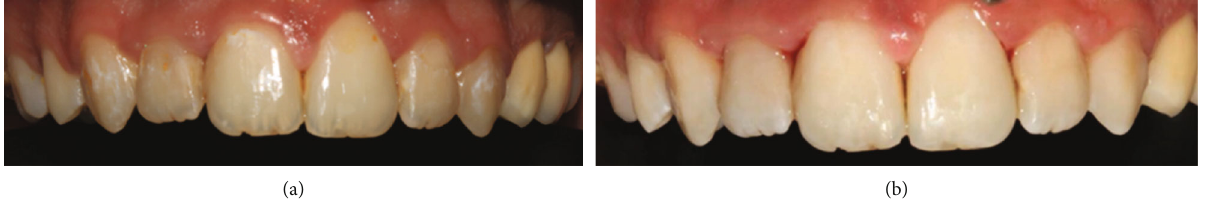
Figure 2: (a) Case 2, pretreatment. (b) Post-treatment with resin in fi